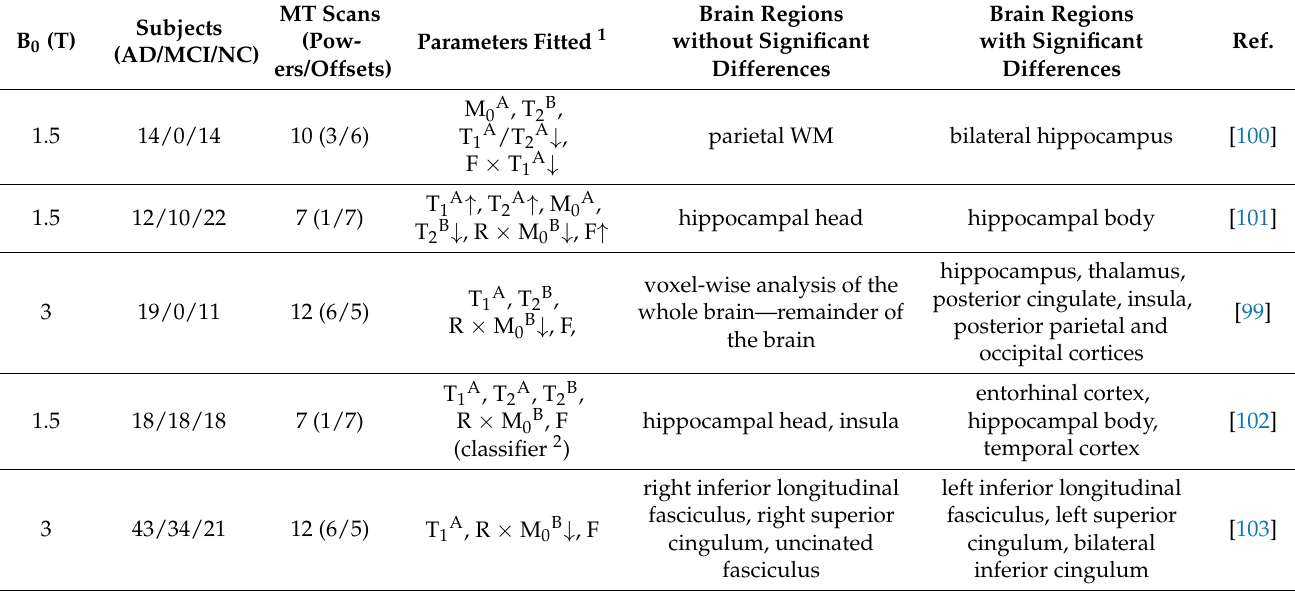
Table 2. Studies of qMT in human brain. qMT parameters which were considered to be significantly different in AD subjects relative to controls are in